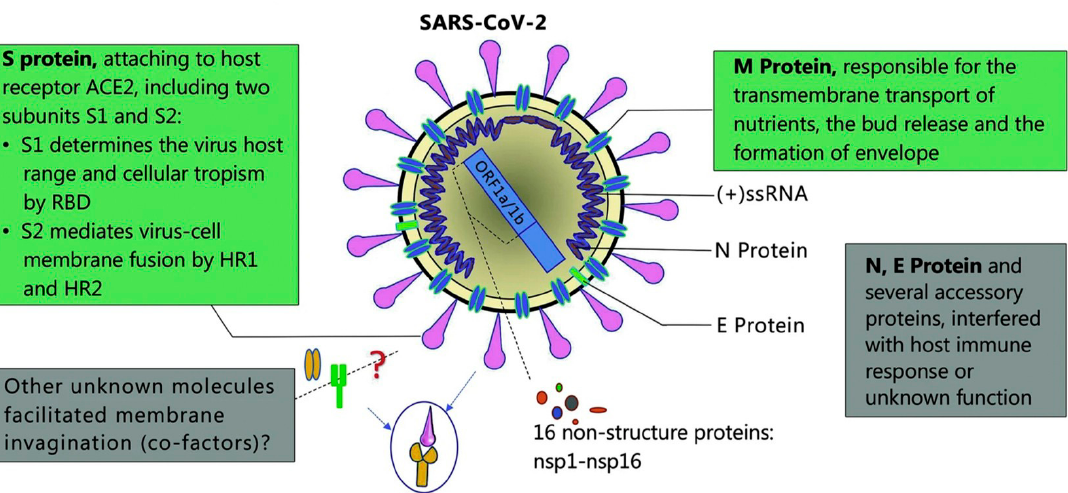
Figure 14. Schematic diagram of the Severe acute respiratory syndrome coronavirus 2 (SARS-CoV-2) structure. Structural proteins, including spike (S) glycoprotein, small envelope (E) protein, matrix (M) protein, and nucleocapsid (N) protein, and also several accessory proteins. Adapted with permission from Guo et al. [78] Copyright © (2020) BMC Springer Nature.